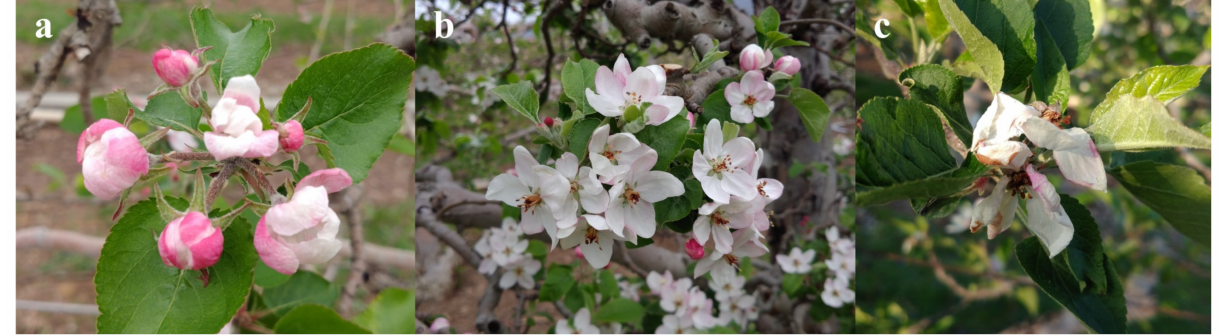
Figure 6. Field photos of apple blossoms at different developmental stages with different sizes: ( a ) small flowers with closed petals; ( b ) large flowers with fully opened petals; ( c ) small flowers with wilted petals.